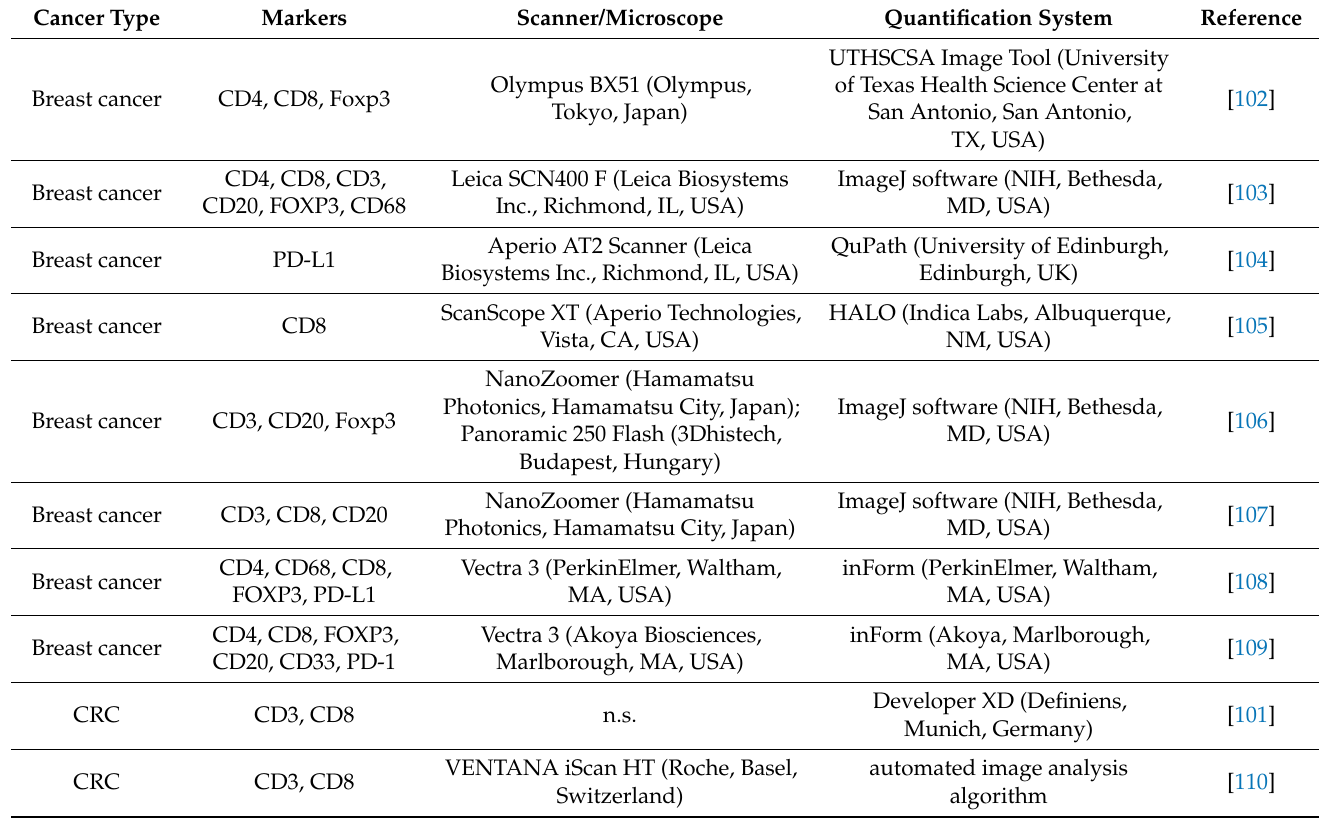
Table 2. Studies using next-generation digital pathology for the assessment of the tumor immune microenvironment. Cancer Type Markers Scanner/Microscope Quantification System Reference